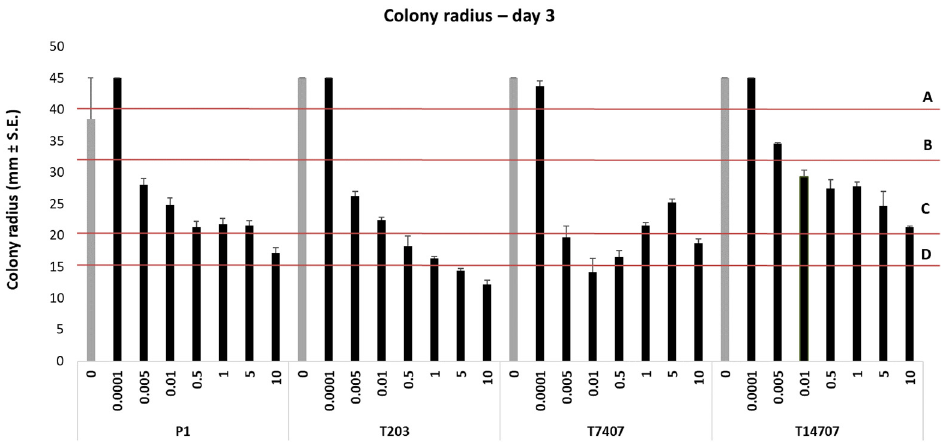
Figure 3. Trichoderma species Azoxystrobin sensitivity assay. The species are T. asperellum (P1), T.